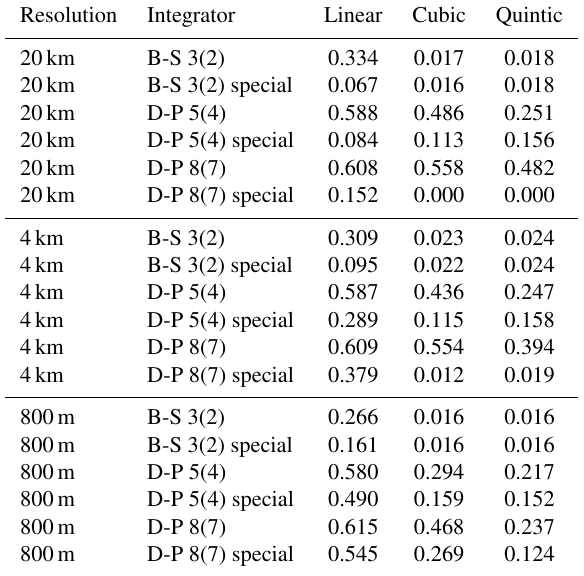
Table 2. Fraction of steps rejected, averaged over all 10000 trajec- tories, with a duration of 72h, for each combination of interpolation scheme and variable-step-size integrator, for all three datasets and a fixed tolerance of T A = T R = 10 − 10 (see Sect.